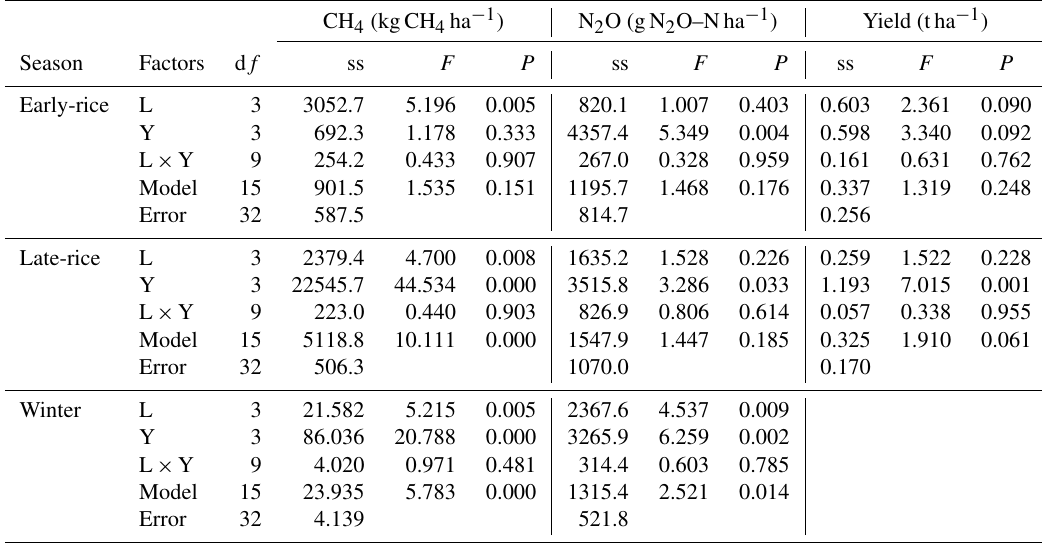
Table 2. Two-way ANOVA for the effects of land management (L) and year (Y) on CH 4 , N 2 O emissions, and rice grain yields.